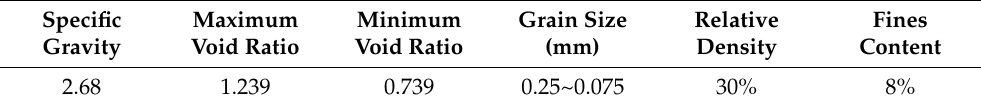
Table 2. Physical properties of gassy